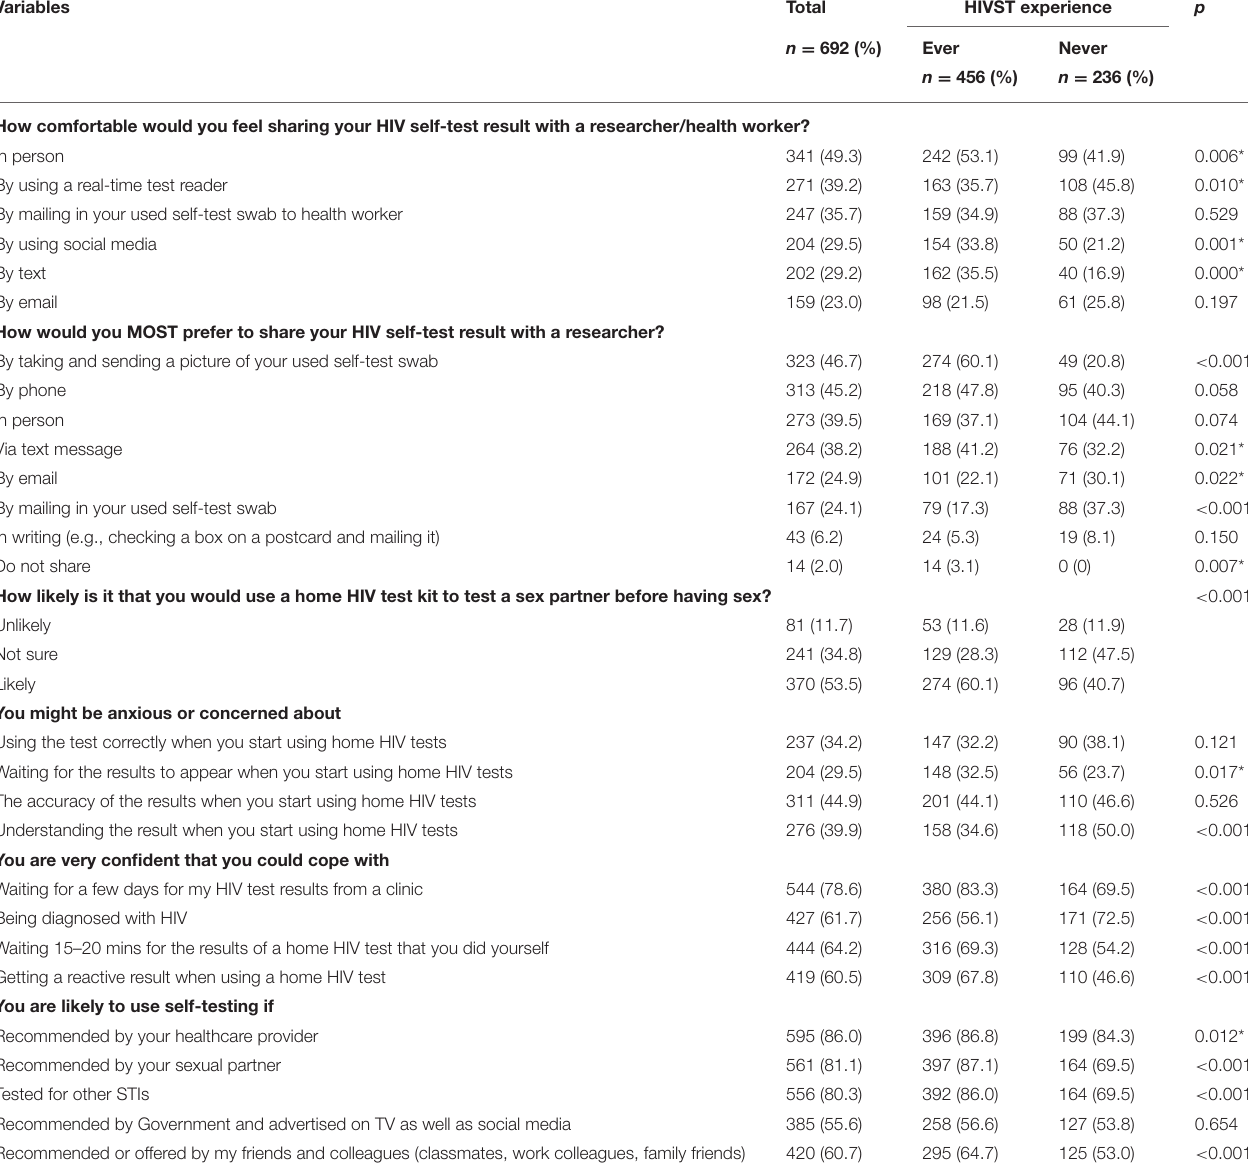
TABLE 3 | Disparities of opinions and belief about HIV self-testing importance between participants whoever self-tested for HIV or not.